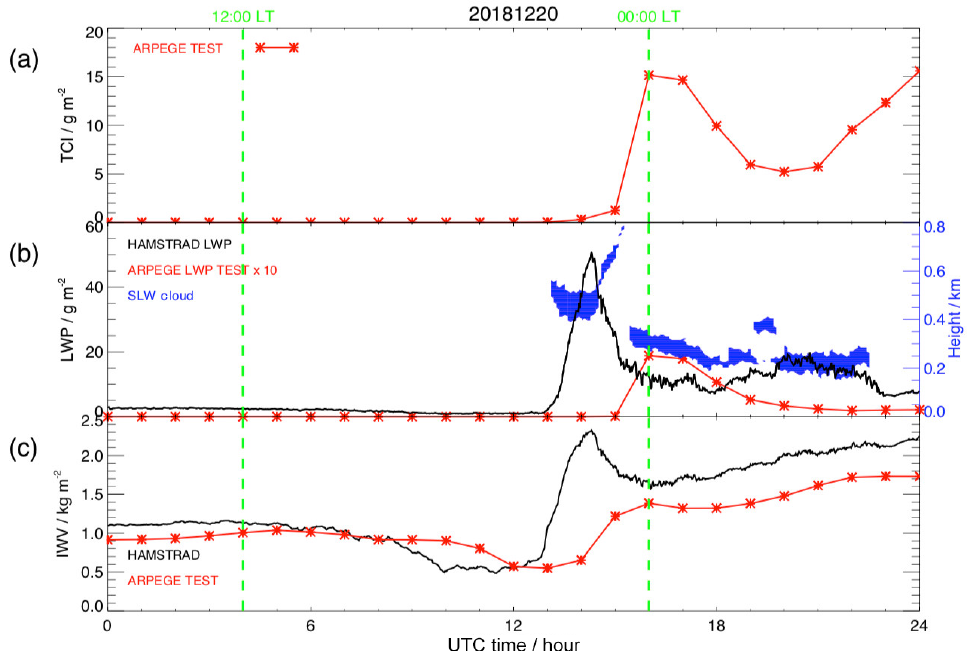
Figure 20. Same as Fig. 19 but on 20 December 2018 (UTC time), and LWP from ARPEGE-SH in test mode has been multiplied by a factor of